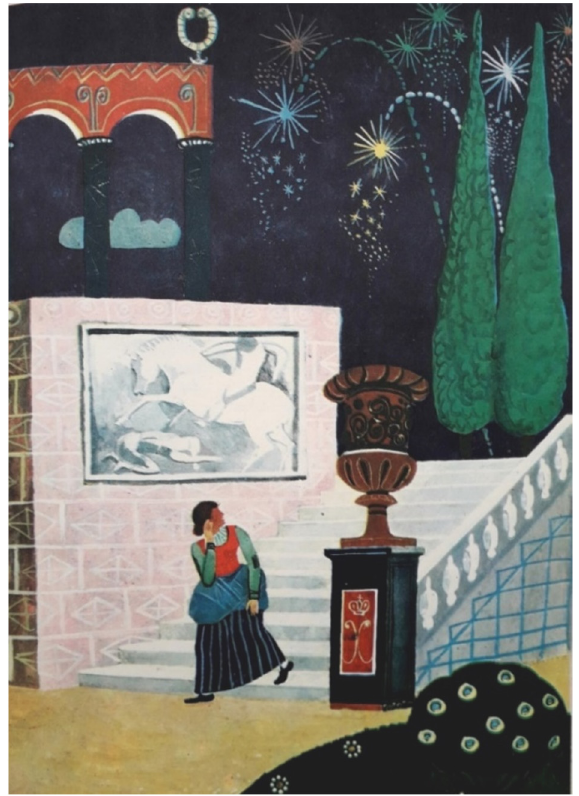
Figure 1. Illustration of Perrault, Charles, Fairy Tales (Cinderella), 1968. Illustrated by Petar Chuklev, Sofia: Narodna Mladezh.